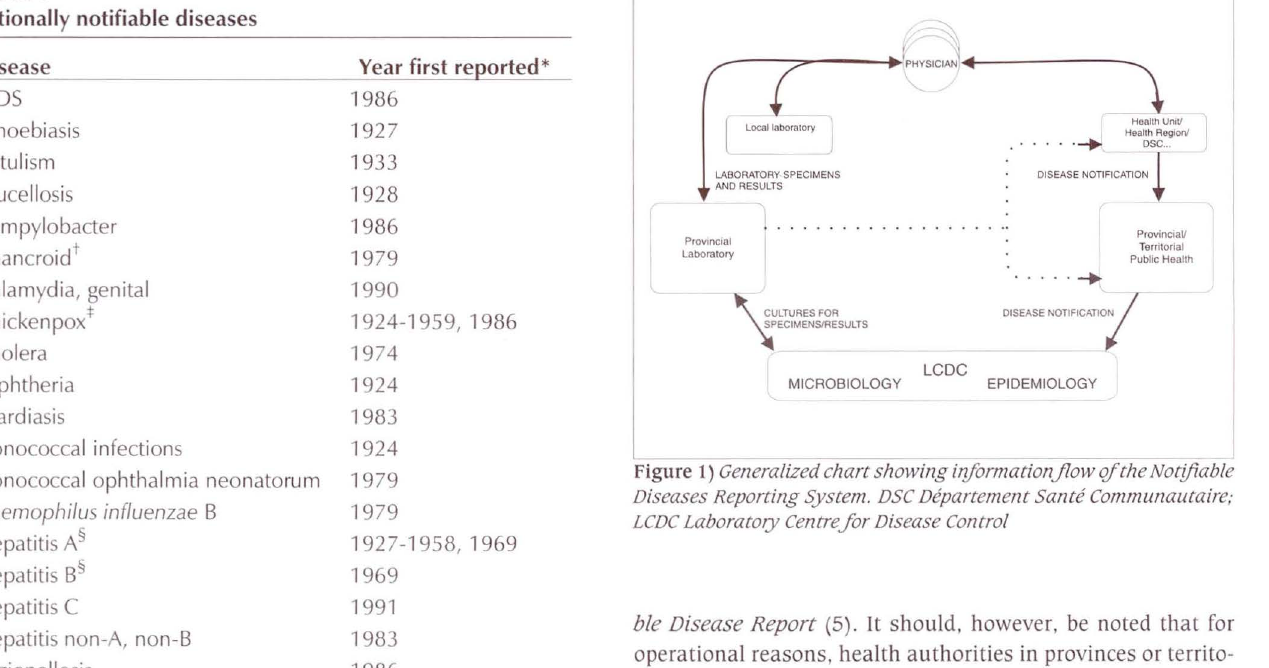
Figure 1) Generalized chart showing iriformation.flow qfthe